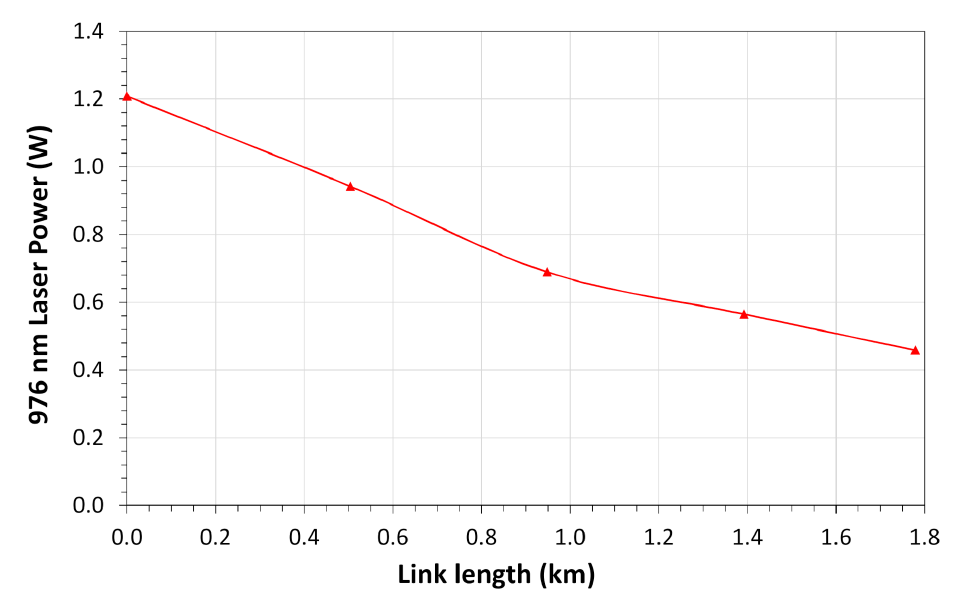
Figure 15. Optical power level to sensor supply versus the link distance. Figure 17 shows the voltage and current collected for approximately 3 months. In this test period, the voltage measured by the system had an RMS value of 8 kV, suitable for a 13.8 kV phase-to-phase grid. The maximum and minimum current measurement for the sensor was 0.51 A and 4.23 A suitable for the typical load of the campus. The measured values of minimum and maximum voltage were 7.67 kV and 8.47 kV respectively with a variation of − 3.78% and 6.35%. Like the previous test, this variation in voltage measurement does not exceed the maximum allowed by Brazilian electricity standards [37], except for the measurement of maximum voltage that exceeds +1.35% from the limit.